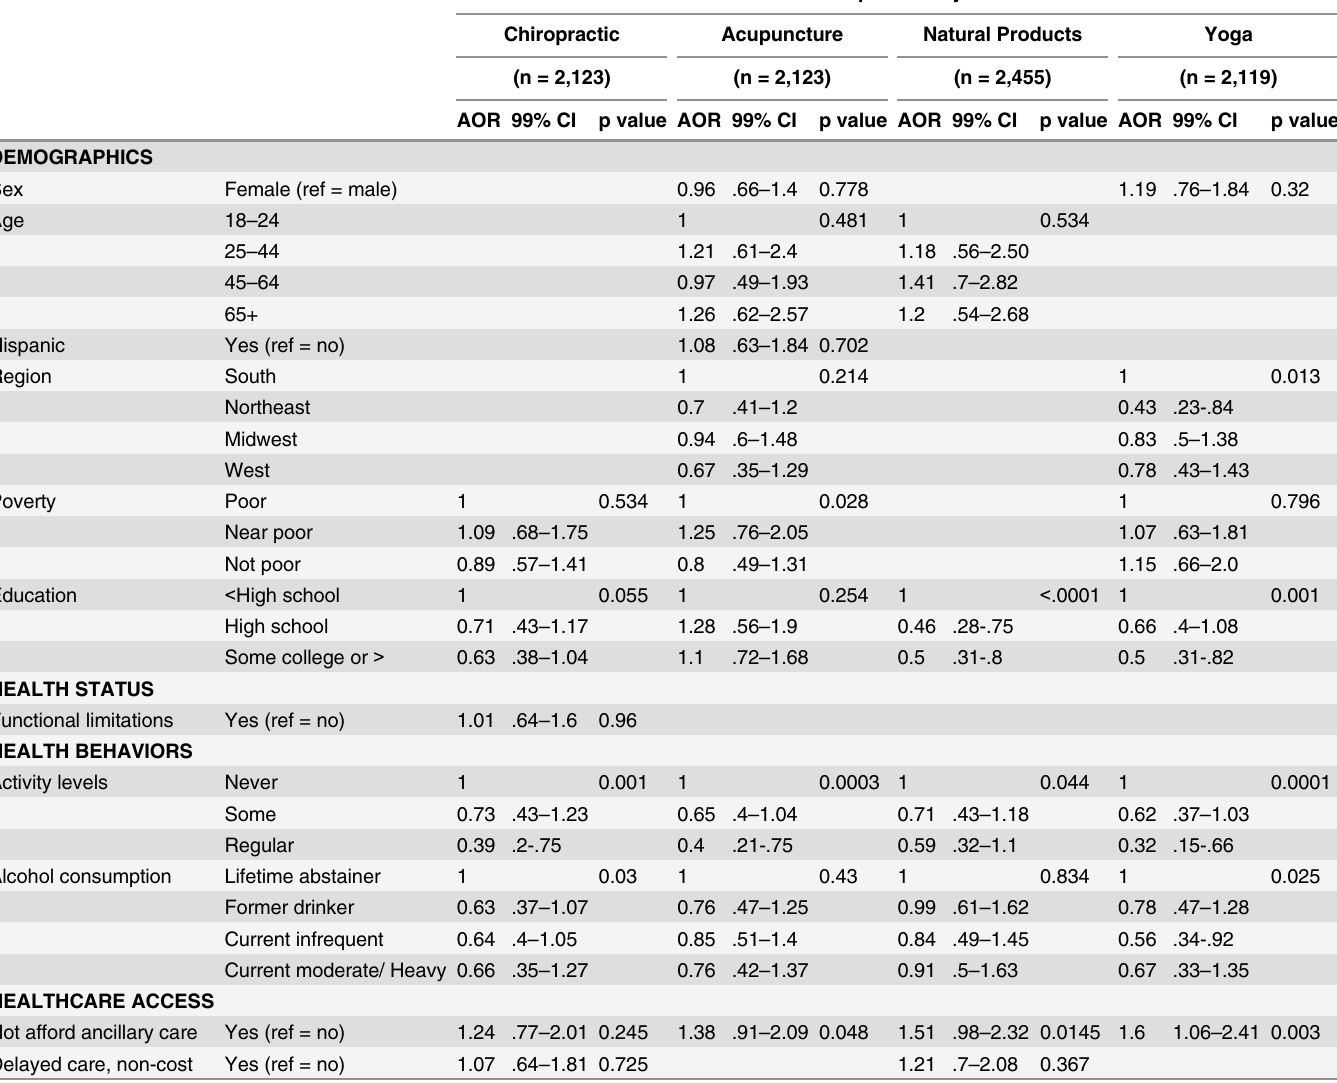
Table 4. Adjusted odds ratios and 99% confidence interval estimates of items independently associated with choosing 'lack of knowledge' as a reason for non-use of four complementary health practices, back pain only